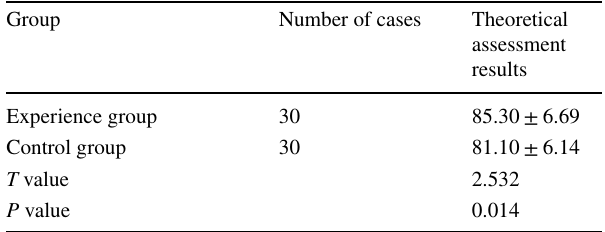
Table 3 Comparison of theoretical scores of two groups of interns after graduation (points)